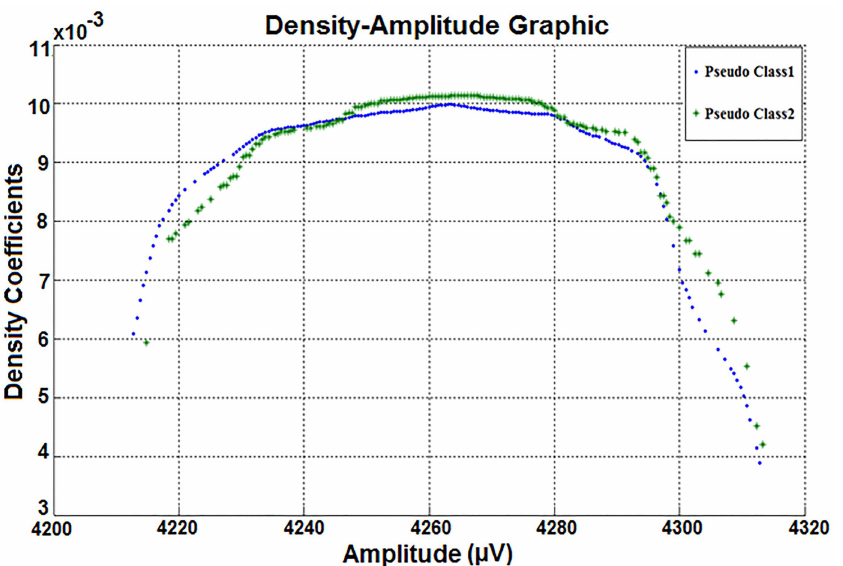
Fig 10. The density-amplitude graph of the 3rd attribute of the dataset (Class-1 is divided to get two fake (pseudo) classes. Both fake classes are related to the ‘eyes open’